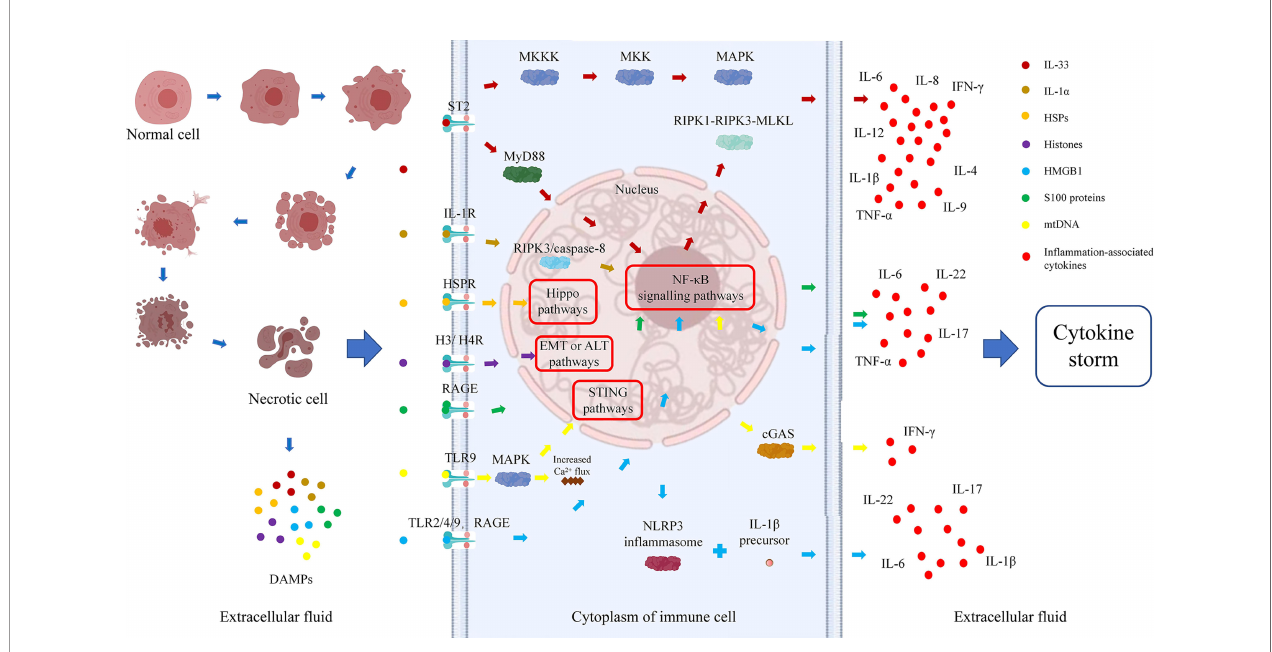
FIGURE 1 | Danger signal cycle: relationships among cell necrosis, DAMPs, and cytokine